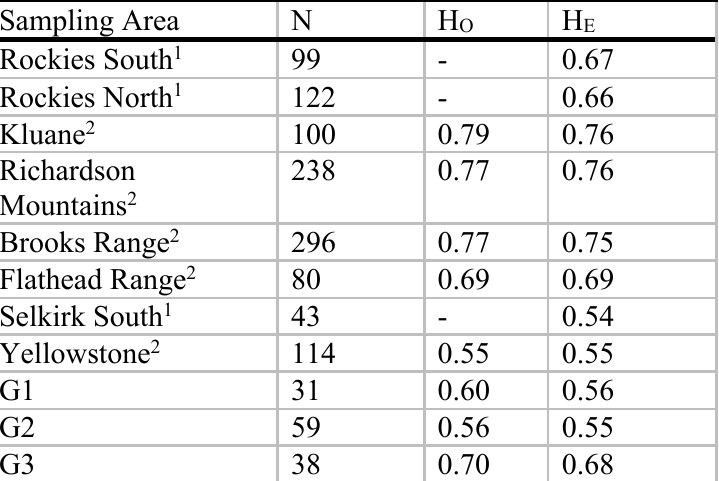
Table A1.3 Observed and expected heterozygosity for North American grizzly bear